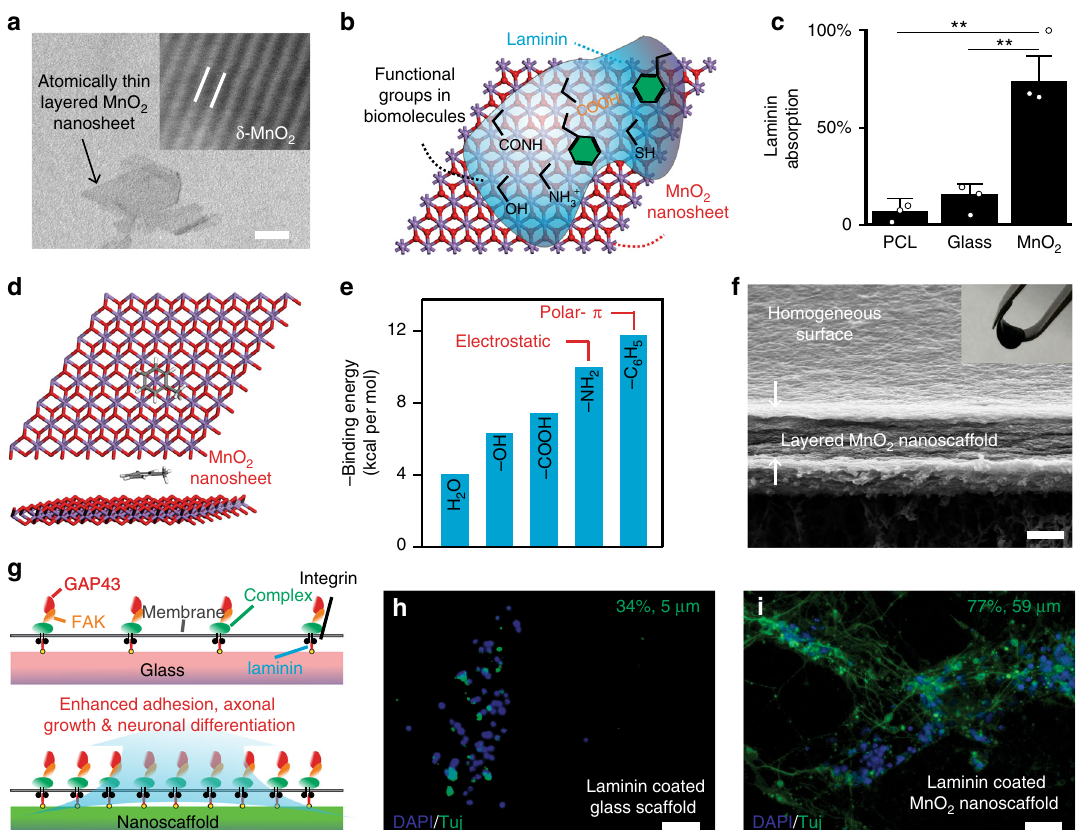
Fig. 2 Enhanced stem cell differentiation using biodegradable MnO 2 hybrid nanoscaffolds. a Representative TEM (Transmission Electron Microscopy) of atomic-thin layered MnO 2 nanosheets. Inset: HR (High Resolution) TEM image (image size: 18 Å by 14 Å). b A schematic diagram describing the intermolecular binding between MnO 2 nanosheets and selected functional groups that are commonly existent in ECM proteins and biomolecules. c A signi fi cantly upregulated ECM protein (laminin) binding towards 2D MnO 2 nanosheet, compared to control substrate [etched glass and polycaprolactone